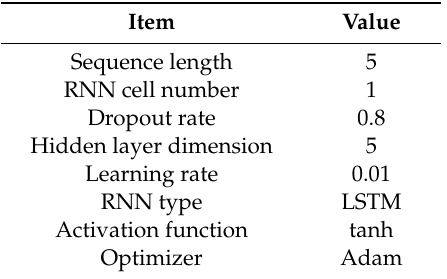
Table 3. Default hyperparameter values and